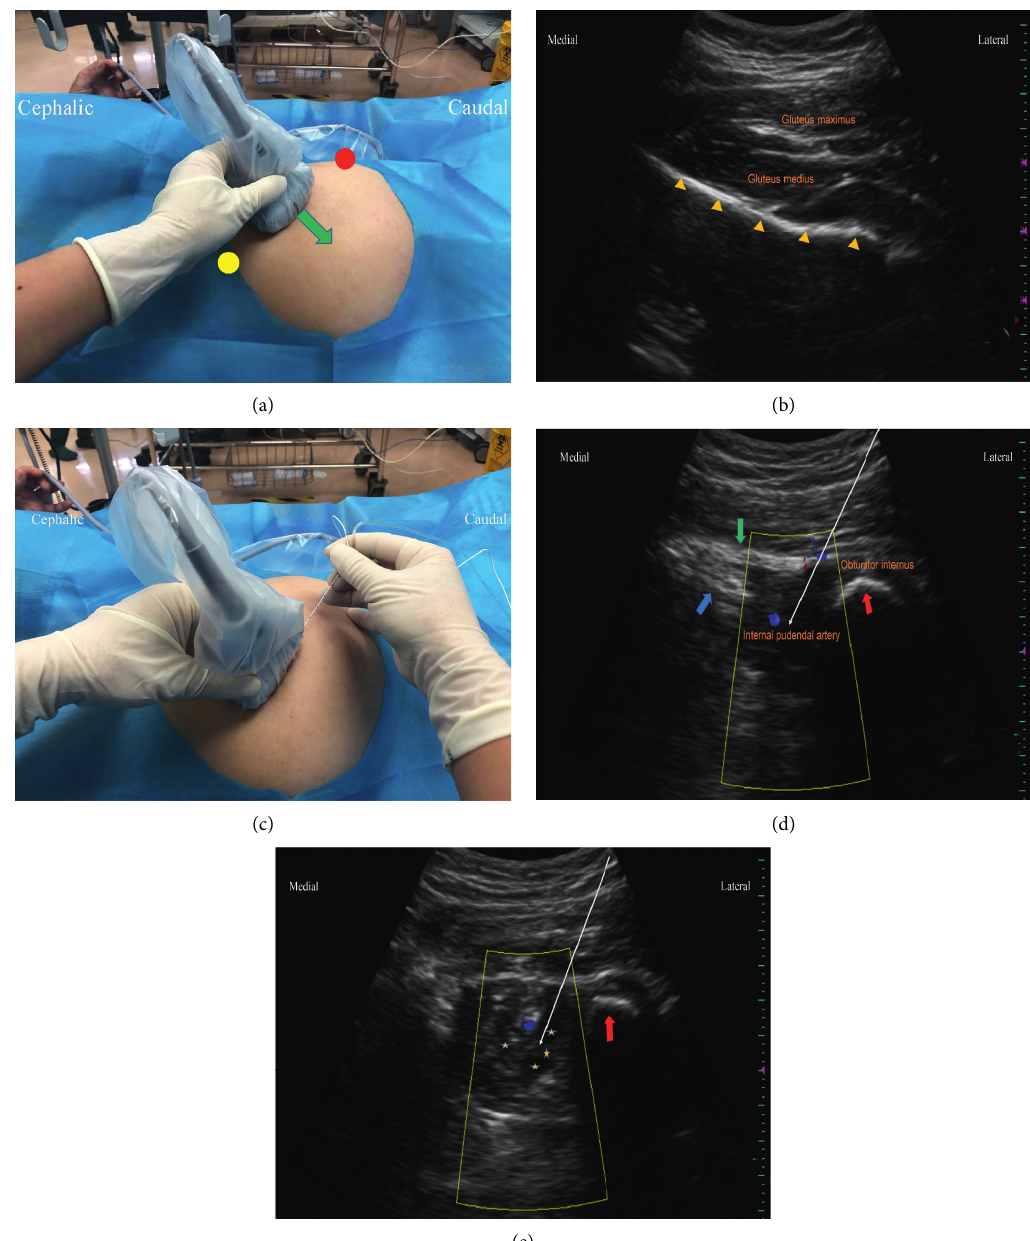
Figure 1: The ultrasound prober location and gray-scale and color Doppler images. (a) The ultrasound transducer is placed at the midpoint of the line connecting the greater trochanter (red circle) and the posterior superior iliac spine (yellow circle). The green arrow indicates the direction of ultrasound transducer movement. (b) The ultrasound image when the transducer is placed at the midpoint of the line connecting the greater trochanter and the posterior superior iliac spine. Hip bone is seen as hyperechoic specular reflectors (yellow triangle). (c) The final position of ultrasound transducer placed and a lateral to medial approach injection. (d) The ultrasound image when the transducer shifts to the lesser sciatic notch. Blue and green arrows indicate sacrospinous and sacrotuberous ligaments, respectively. The red arrow indicates ischial tuberosity. The internal pudendal artery (blue Doppler signal) lies in the corner between the coccygeus and internal obturator muscles. The white arrow indicates needle trajectory and injection point. (e) The ultrasound image after anesthetic injection around the internal pudendal artery. The pentagram represents the spread of local